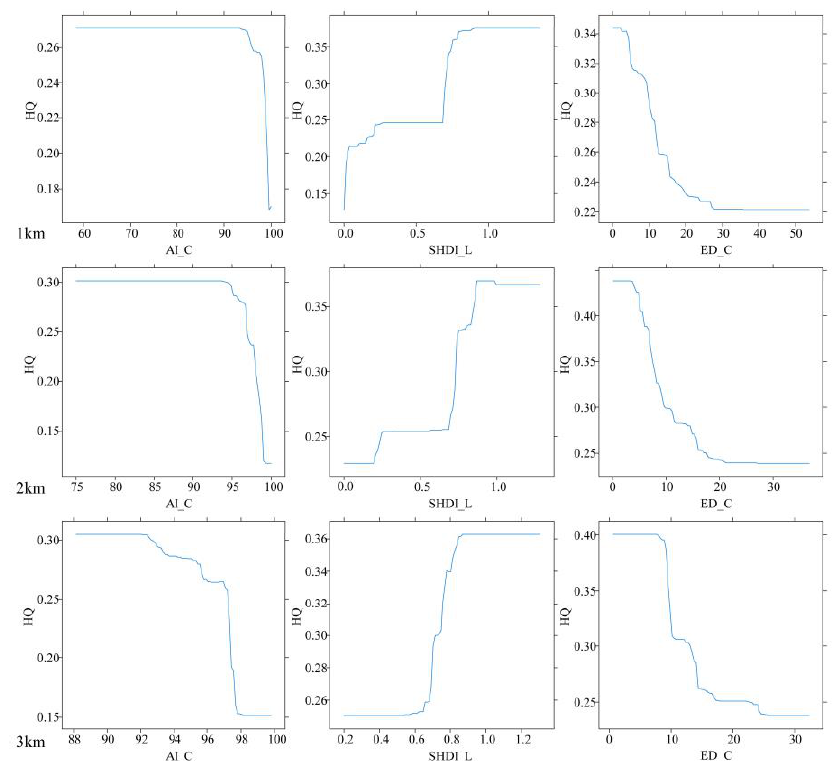
Figure 6. The partial dependence plot of HQ on the three most important landscape metrics at different spatial scales.